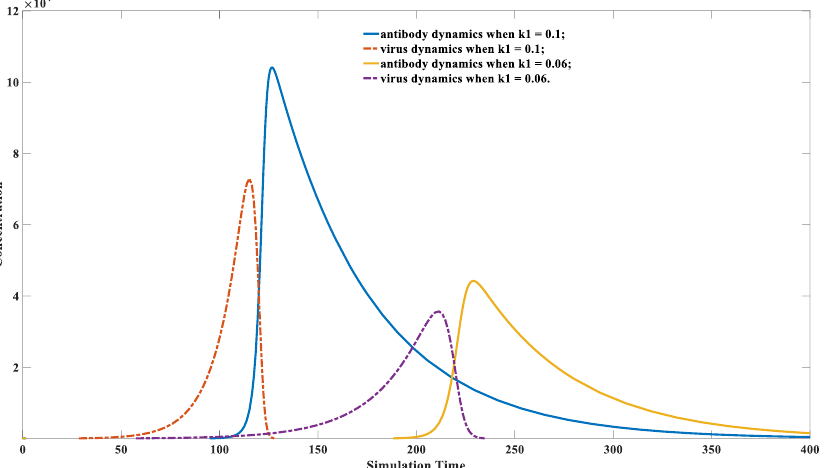
Figure 5. Different immune behaviors toward variants with different replication activities. The parameter set we used is: x (0) = 0, y (0) = 100, z (0) = 10, p (0) = 1000, k 1 = 0.06 or 0.1, k 2 = 1 × 10 − 5 , k − 2 = 1 × 10 − 14 , k 3 = 1, k 4 = 2, k 5 = 0.02, k 6 = 0.02, k 7 = 1 × 10 − 8 , k − 7 = 1 × 10 − 14 . As shown in this figure, the antibody response is milder when the host is infected by a less toxic strain (smaller k 1 value 0.06). The peak viral load is also less compared to its high toxic counterpart (bigger k 1 value 0.1). This indicates that even for the same virus infection, the immune response would vary greatly due to the differences in viral replication capacity of different